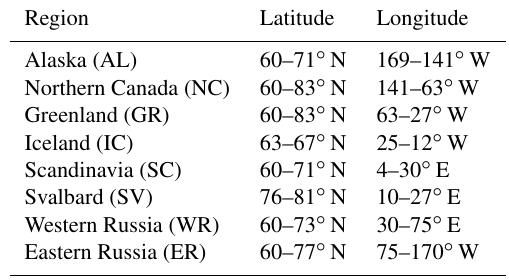
Table 3. Latitude–longitude range of each